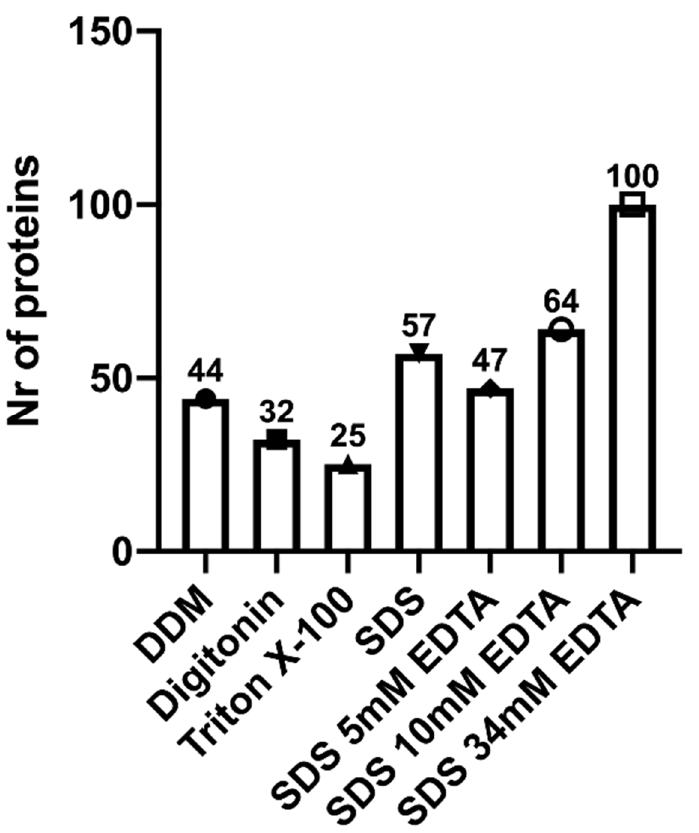
Figure 3. Number of high confidence unique proteins identified following tandem-MS/MS analysis of human milk extracellular vesicles under seven different denaturing conditions. SDS with and without EDTA at 5 mM, 10 mM and 34 mM concentrations, Digitonin, n-dodecyl β -D-maltoside (DDM), and Triton X-100 were tested as detergents, n = 1. Mass spectrometry analysis from samples processed with each detergent revealed SDS with 34 mM of EDTA to be the optimal detergent based on the highest number of unique proteins identified.